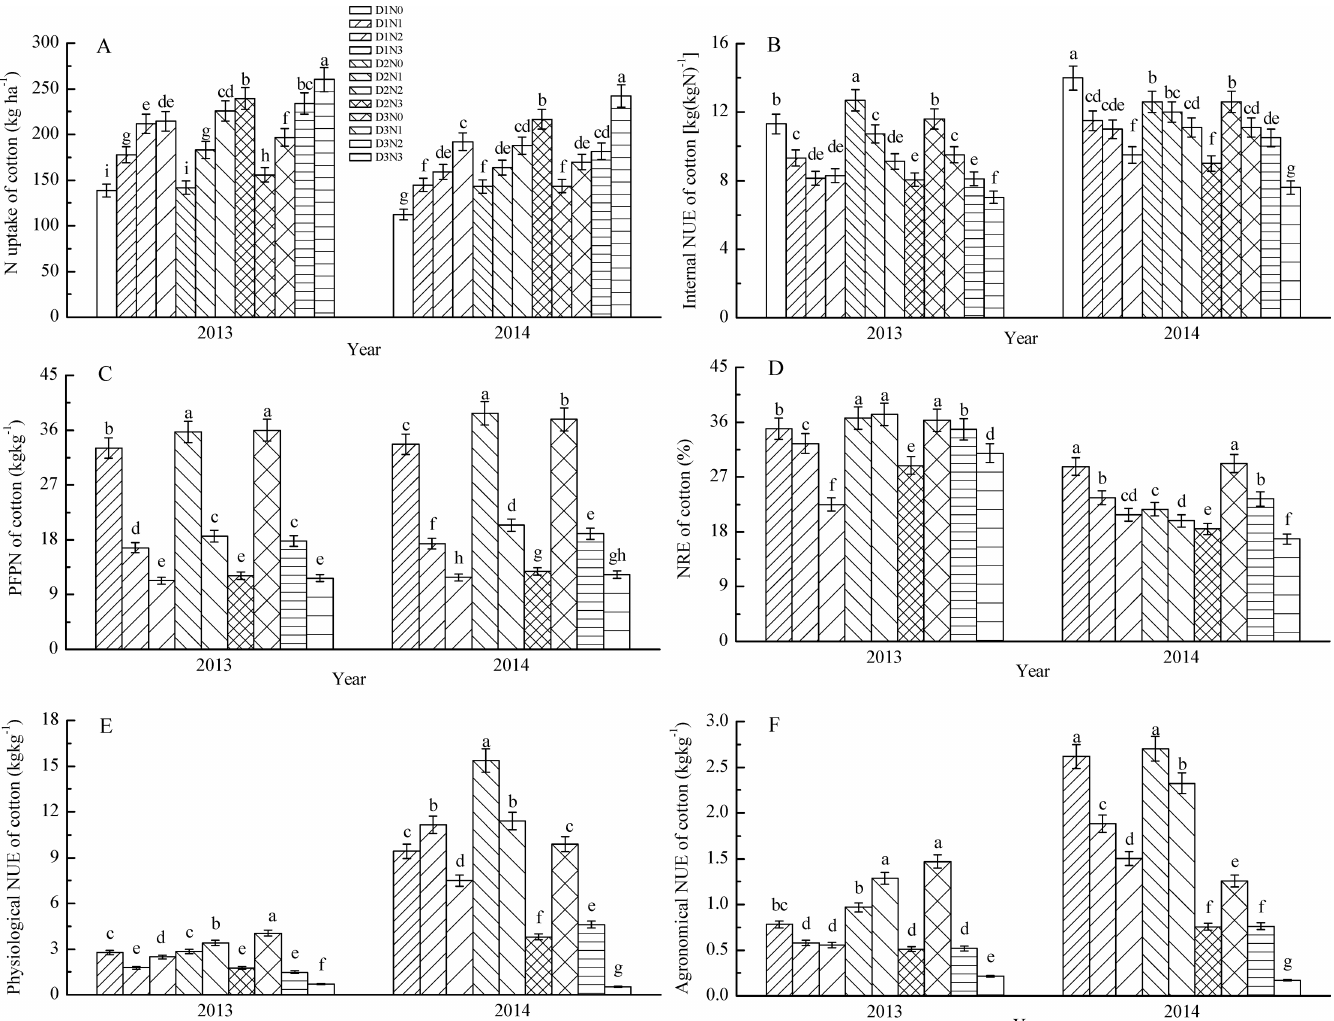
Fig 2. N uptake of cotton(A), internalnitrogenuse efficiencyof cotton(B), partial factor productivityfrom appliednitrogenof cotton(C),nitrogen recovery efficiency of cotton(D), physiological nitrogenuse efficiencyof cotton(E) and agronomic nitrogenuse efficiency(F) of cotton in 2013 and 2014Note:D1, D2, D3 indicate plantingdensity at 3.00, 5.25, 7.50 plants m − 2 respectively,and N0, N1, N2, N3, N4 indicatenitrogenapplicationrate at 0, 112.5, 225.0, 337.5 kg ha − 1 respectively.Numbers for the same year followedby the same small alphabetare not significantly different at the 5%